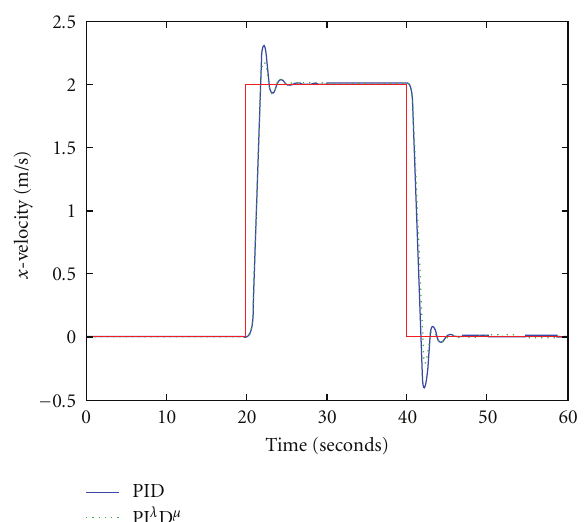
Figure 17: Time response of the system under the action of the PID and PI λ D μ